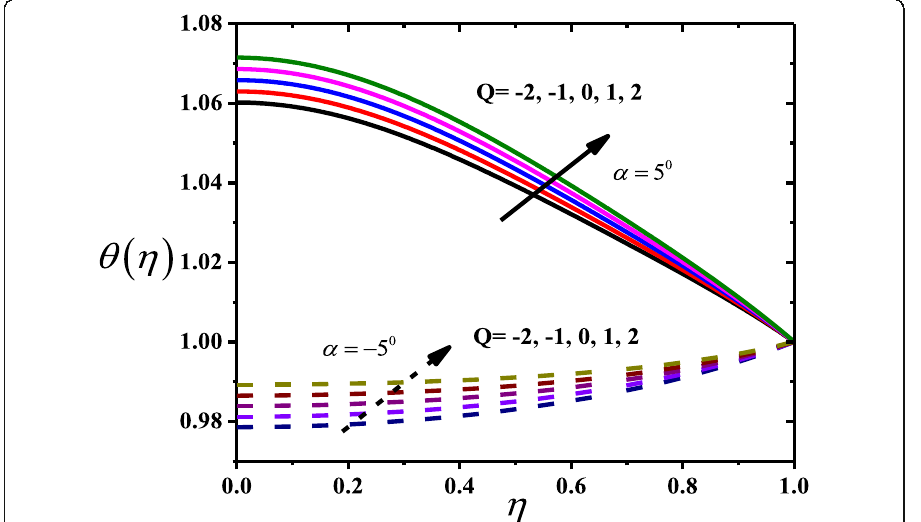
Fig. 13 Temperature vs. Q in shrinking divergent and stretching convergent